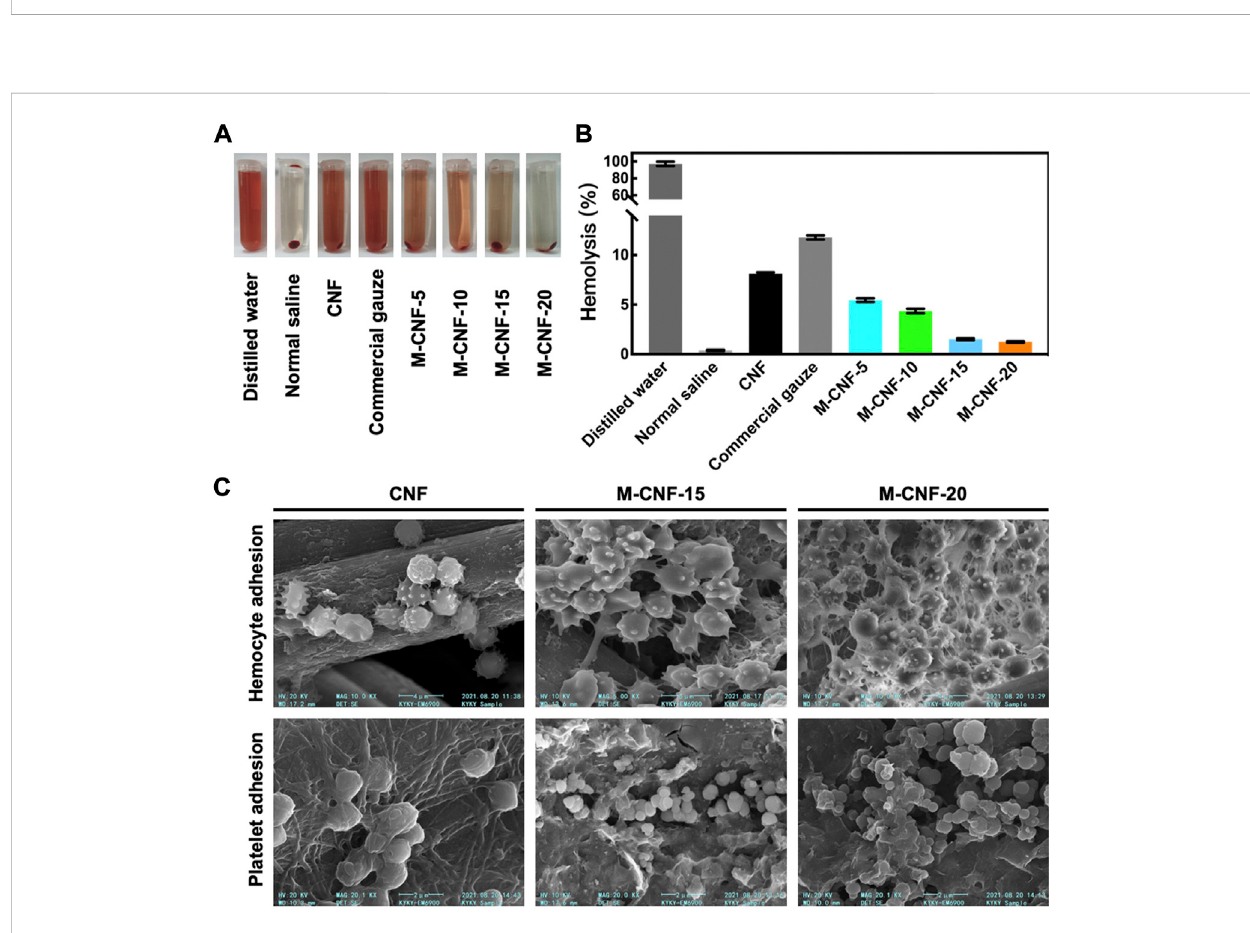
Hemostatic ability of MXene modi fi ed material M-CNF (A, B) Hemolysis image and hemolysis ratios of the M-CNF-x extracts. (C) SEM images of blood cells and platelets adhesion on the CNF, M-CNF-15 and M-CNF-20 surface (Li et al.,